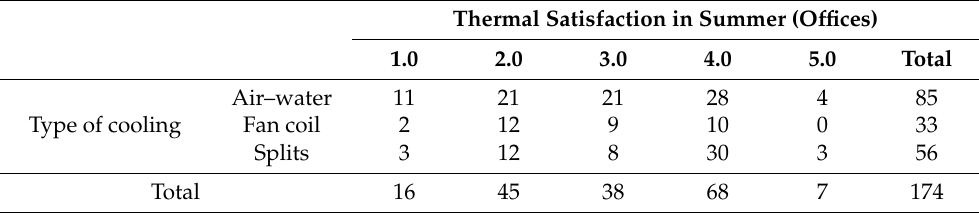
Table 6. Contingence table for thermal satisfaction in summer (offices) and type of